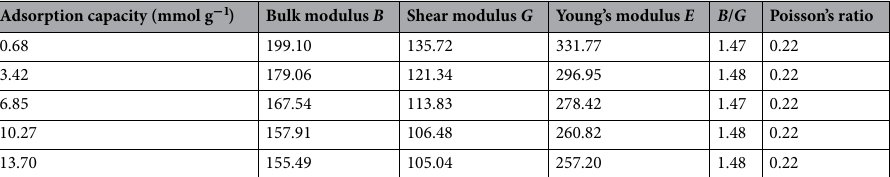
Table 2. The bulk modulus, shear modulus, Young’s modulus, B/G and Poisson’s ratio changed by adsorption